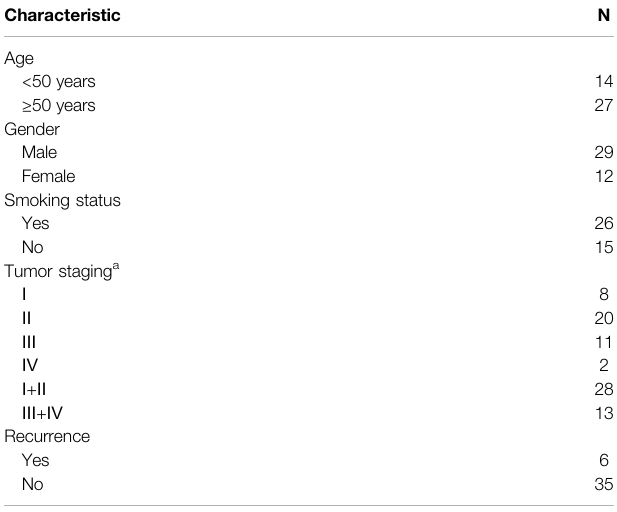
TABLE 1 | Characteristics of 41 patients with